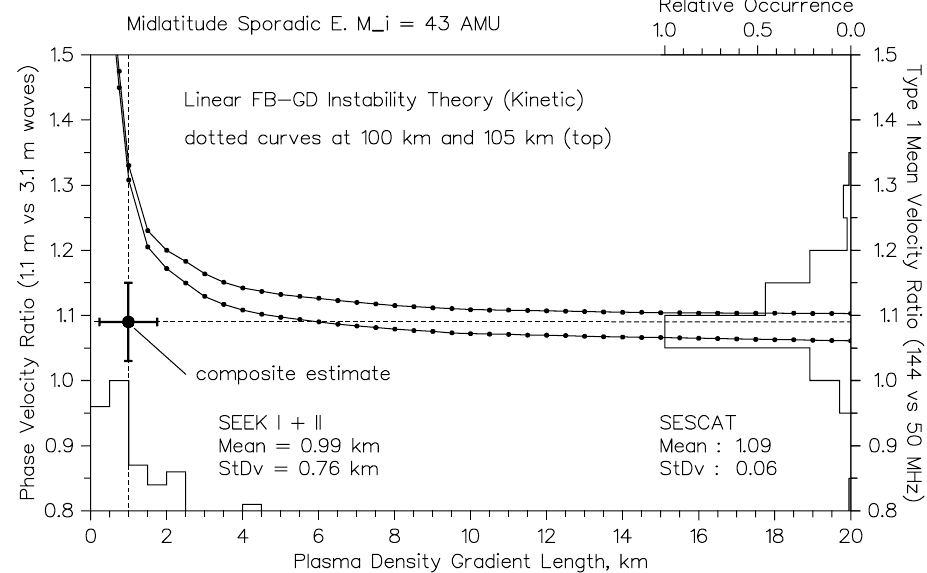
Fig. 6. The SESCAT dual frequency backscatter observations of 144- to 50-MHz type 1 velocity ratios are compared to the kinetic theory predictions for mid-latitude sporadic E plasma. Also shown in the lower left corner is the distribution of destabilizing gradient lengths measured by the SEEK rockets during sporadic E plasma instabilities. The composite estimate, shown to the left, is based on the distribution mean values under the assumption that the measured mean gradient lengths are representative of type 1 echo conditions. This comparison shows that the 1.10-m to 3.15-m type 1 velocity ratio is not affected, on average, by gradient drift instability